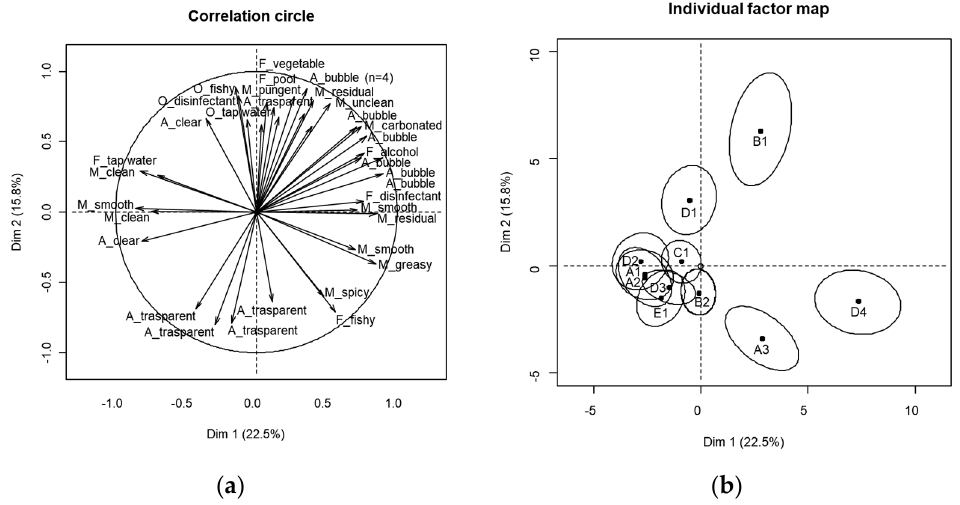
Figure 2. ( a ) Multiple factor analysis of free-choice profiling (FCP); ( b ) confidence ellipses of sample configurations of FCP.